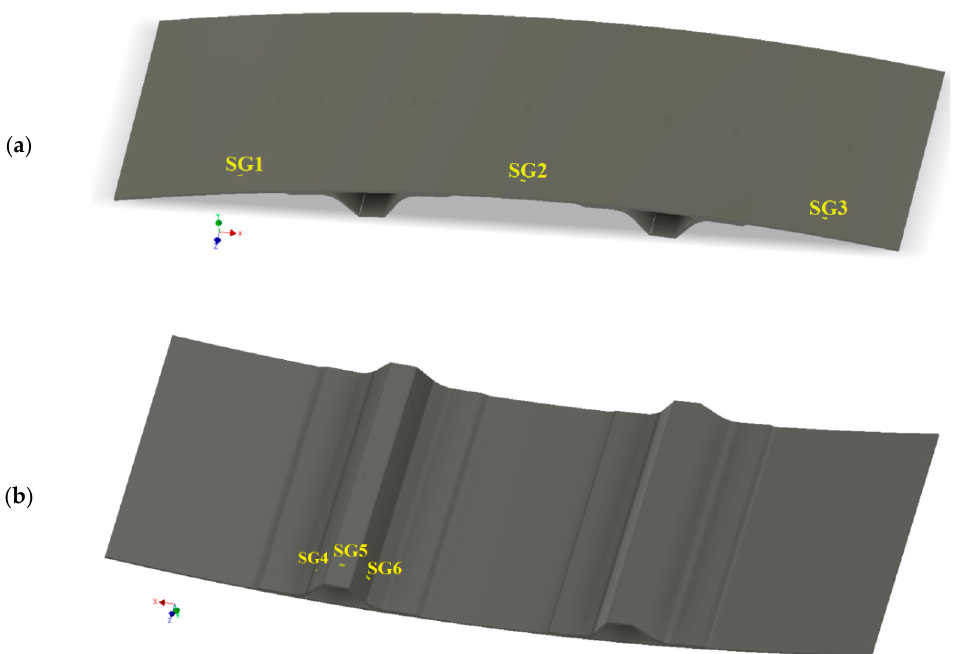
Figure 4. Mounting locations of strain gauges: ( a ) view from top and ( b ) view from bottom.